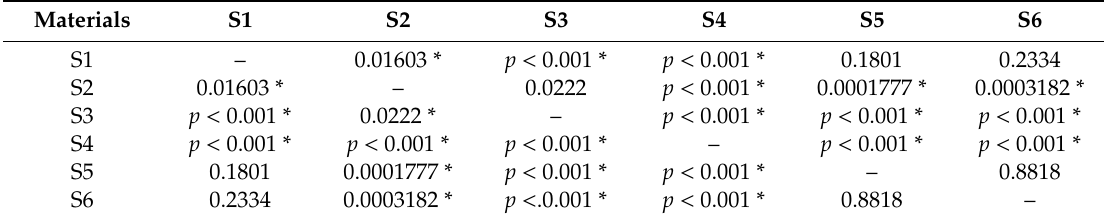
Table 6. Di ff erences in ∆ E after 168 h immersion in Coca-Cola ® .